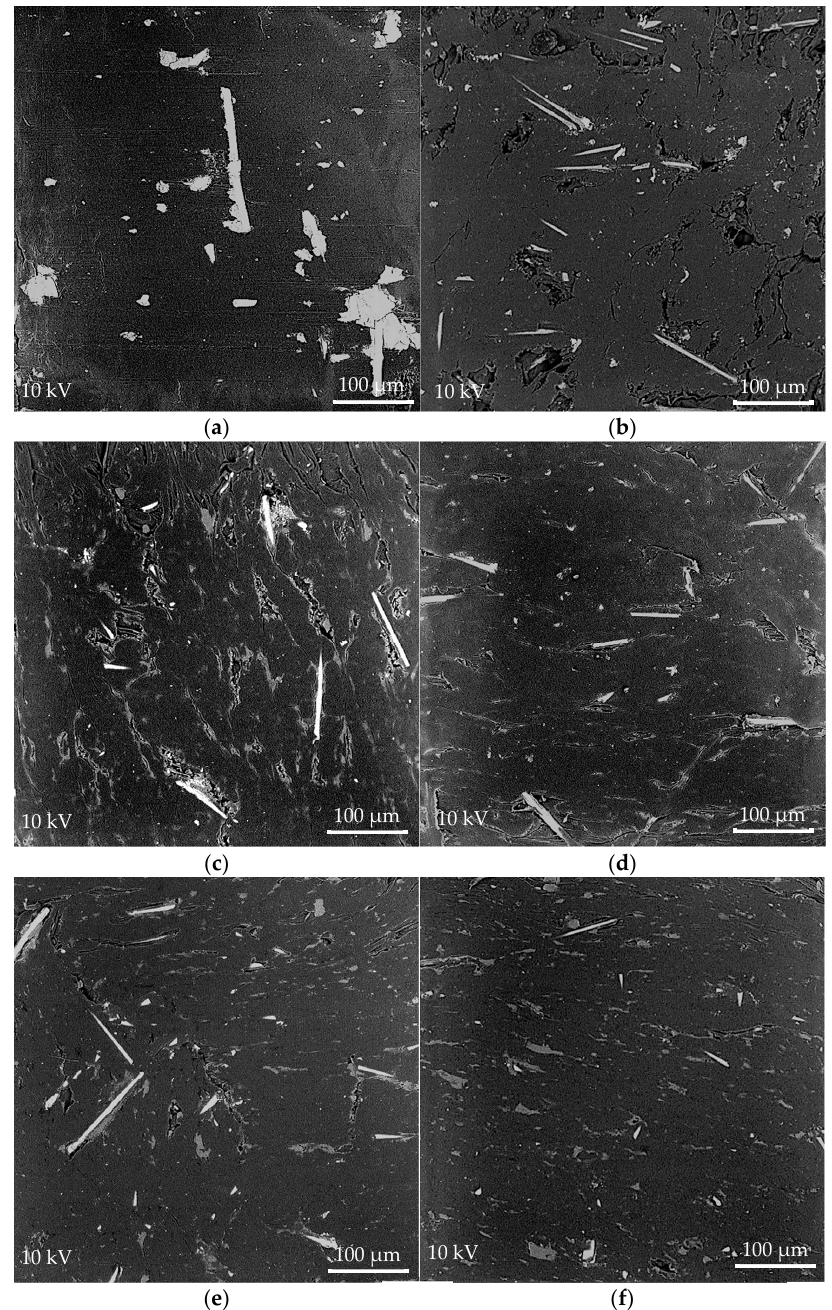
Figure 5. SEM micrographs of POM/GF/PTFE composites worn surfaces after tribology test: ( a ) POM-GF-PT0; ( b ) POM-GF-PT1.7; ( c ) POM-GF-PT4.0; ( d ) POM-GF-PT9.5; ( e ) POM-GF-PT15.0; ( f )